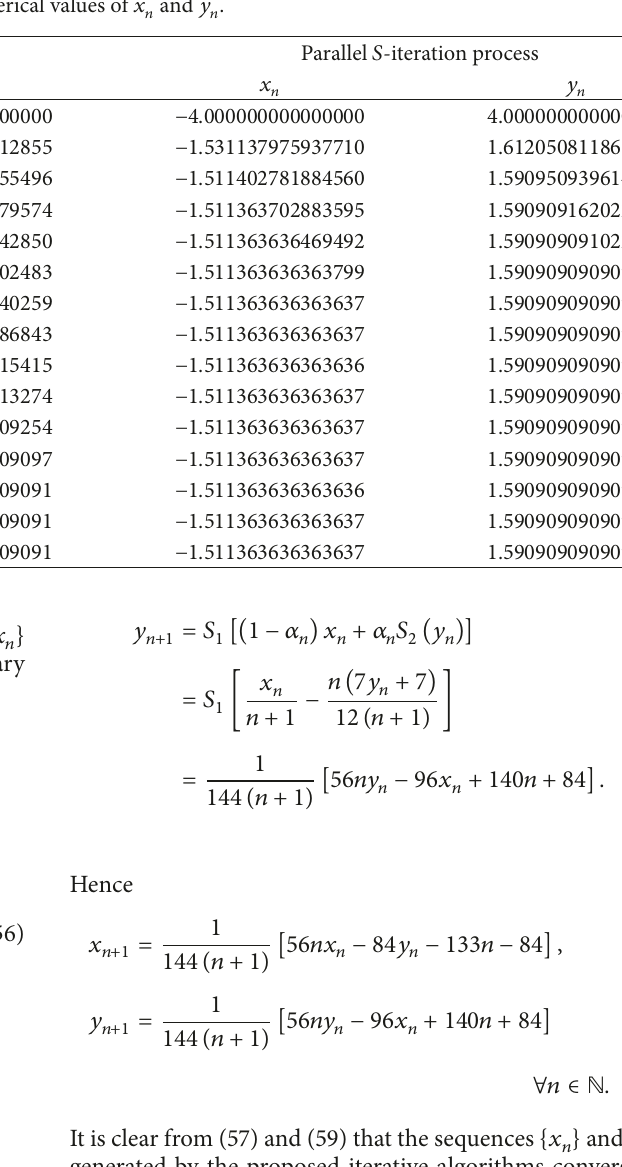
Table 1: Numerical values of 𝑥 𝑛 and 𝑦 𝑛